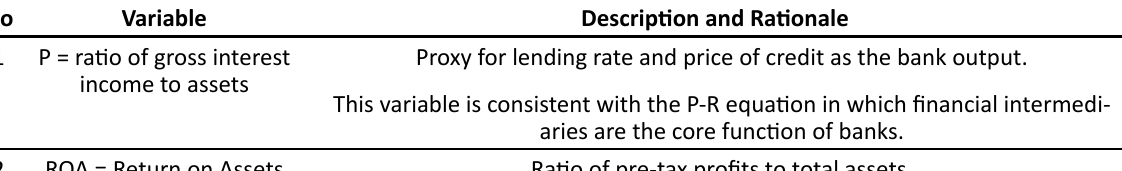
Table 1: Description of